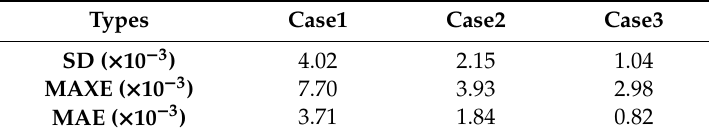
Figure 10. DOP-error comparison of three cases. ( a ) DOP-error curve comparison; ( b ) DOP error distribution; ( c ) SD of DOP-error comparison. Table 4. Statistics comparison of DOP error. Table 4. Statistics comparison of DOP error.